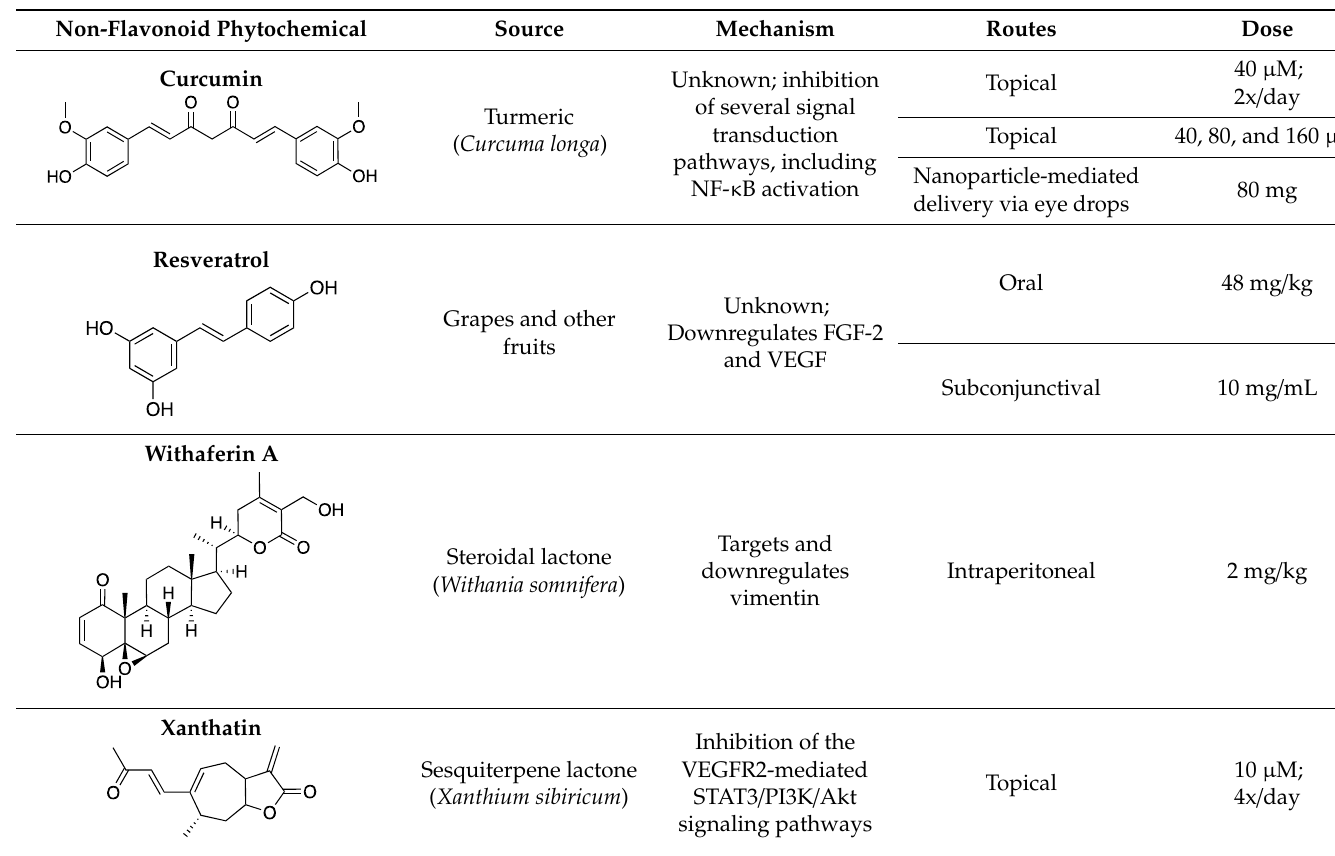
Table 5. Non-flavonoid phytochemicals tested in CoNV models.